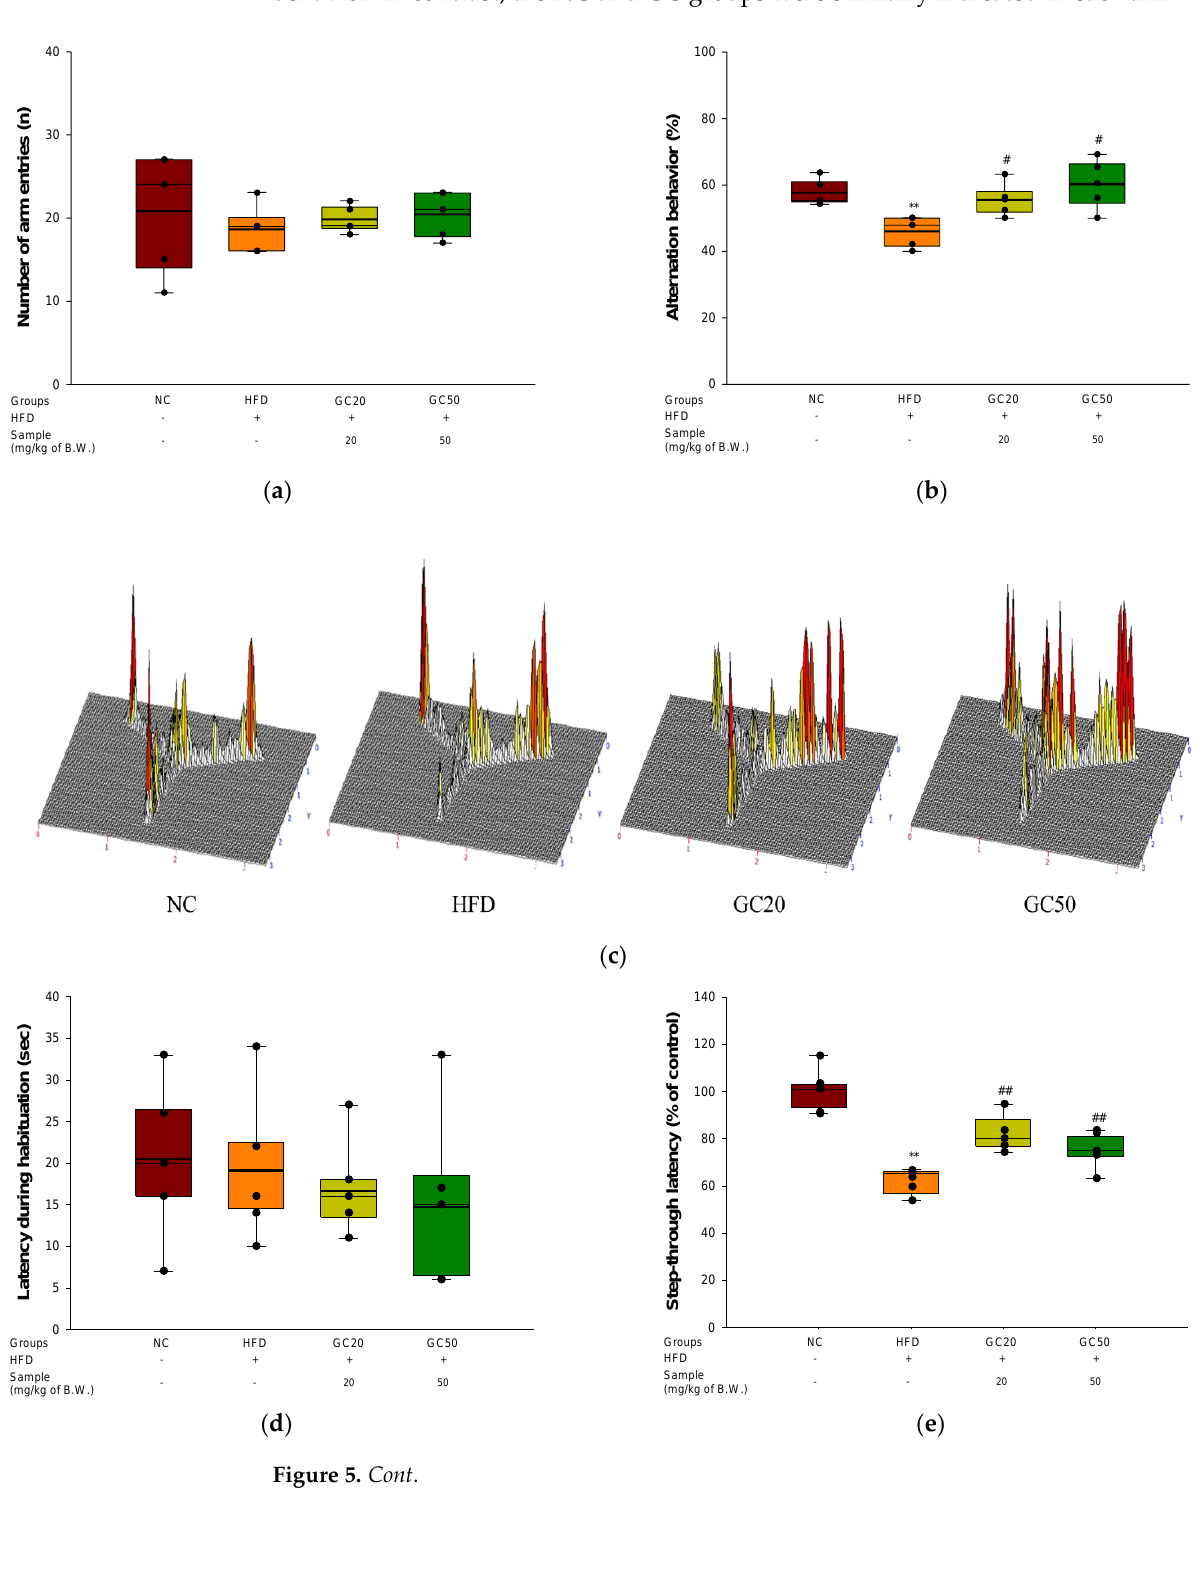
( g ) ( h ) Figure 5. Protective of 80% ethanolic extract from Gimcheon 1ho (GC) cultivar walnut ( Juglans regia ) in HFD-induced mice: ( a ) a number of arm entries; ( b ) spontaneous alternation behavior; ( c ) 3D moving routes in Y-maze test; ( d ) latency during habituation; ( e ) step-through latency in passive avoidance test; ( f ) escape latency in the hidden test; ( g ) retention time in W zone; ( h ) path tracing of each group in Morris water maze (MWM) test. Results shown are mean ± SD ( n = 5). Data are statis- tically represented with * = significantly different from the NC group, and # = significantly different from PM group; * and # p < 0.05, ** and ## p < 0.01. Bold line indicates mean.